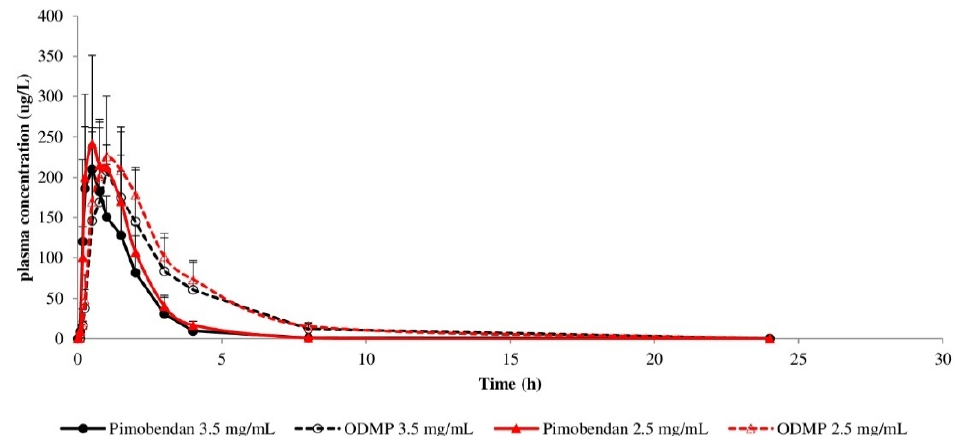
Figure 1. Time course of plasma pimobendan and ODMP concentrations (mean ± SD) in dogs. The pimobendan oral solution formulation (2.5 mg/mL) and reference solution formulation (3.5 mg/mL) were administered at a dose of 0.3 mg/kg in a crossover fashion (n = 4 for each formulation). Table 1. Comparison of pharmacokinetic parameters between pimobendan oral solution formula ‐ tion (2.5 mg/mL) and reference solution formulation (3.5 mg/mL) after 0.3 mg/kg oral administration in healthy beagle dogs (n = 4 for each formulation).